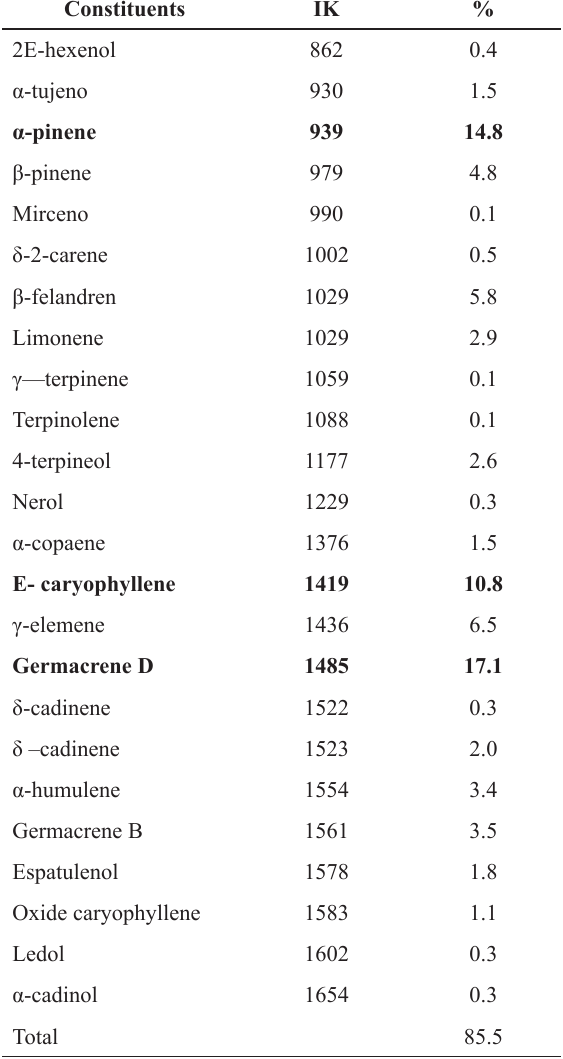
Chemical composition of the leaves of the essential oil from Myroxylon peruiferum L.f